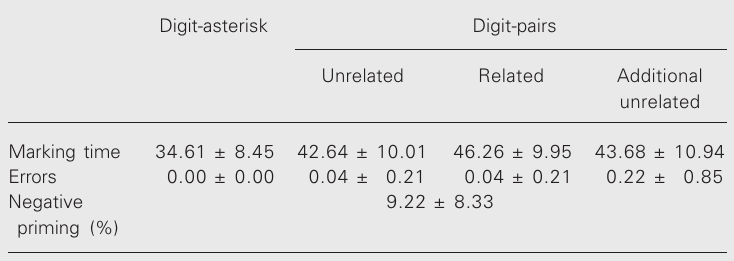
Table 1. Marking time and errors for the paper-and-pencil digit-comparison task in Experiment